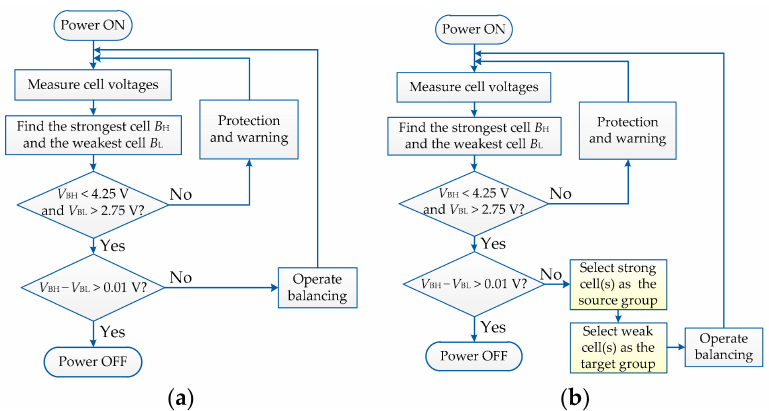
Figure 11. Control algorithms of the simulation models. ( a ) QRSCC equalizer. ( b ) The other three equalizers.